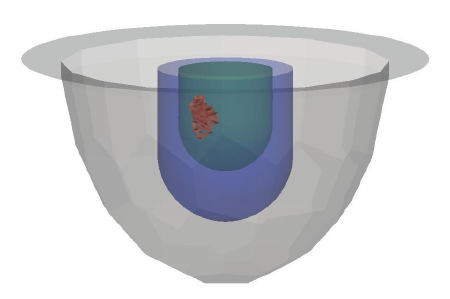
Figure 1. Simulated Breast Model. Gray, blue, green, and red regions represent air, fat, fibroglandular, and tumor,